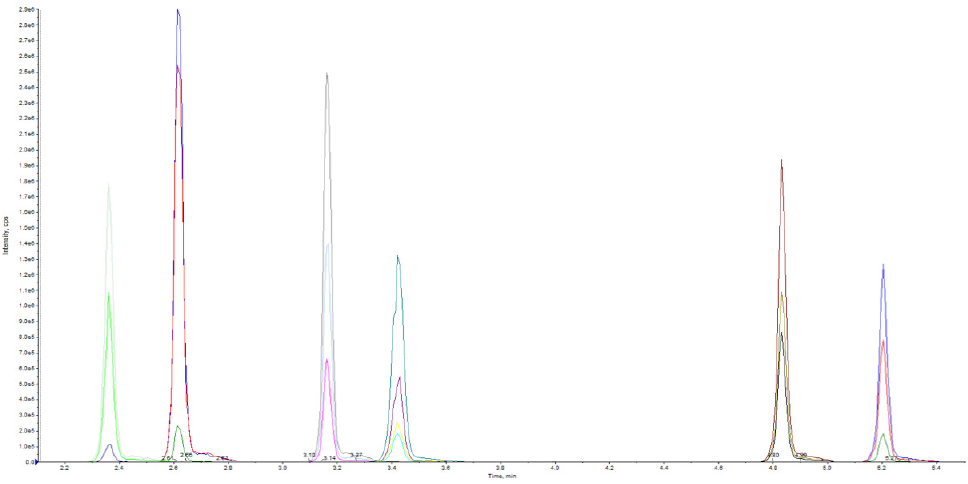
Figure 2. MRM extracted ion chromatogram of methanol standard solution.